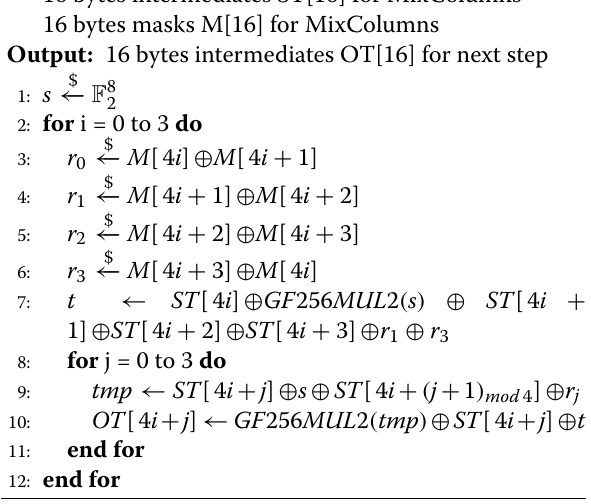
Algorithm 4 Secure and efficient proposal of one